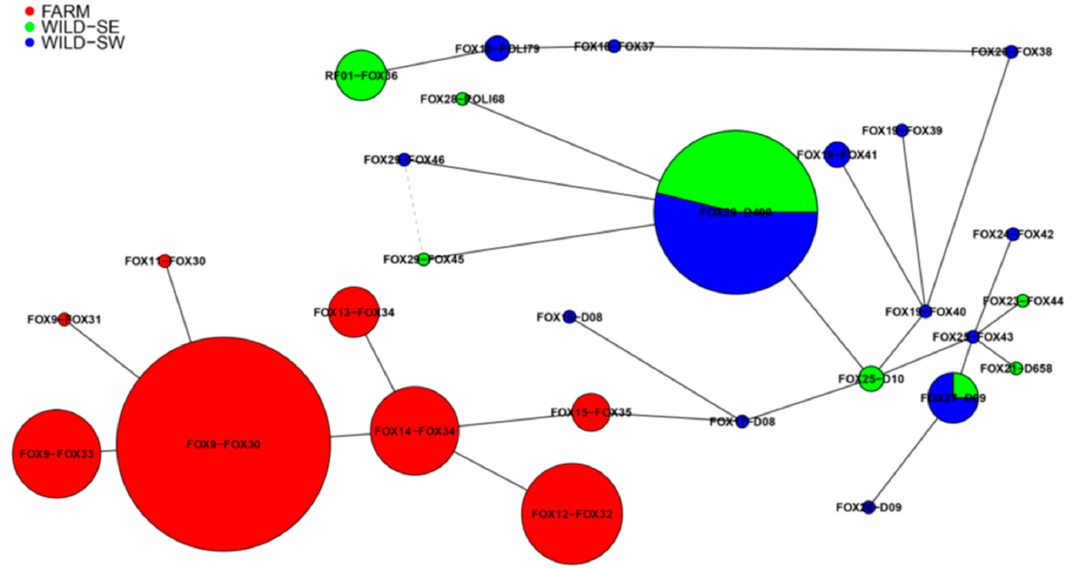
Figure 5. Haplotype network showing relationships between concatenated haplotypes of farm and wild red foxes. The size of the circle represents the haplotype